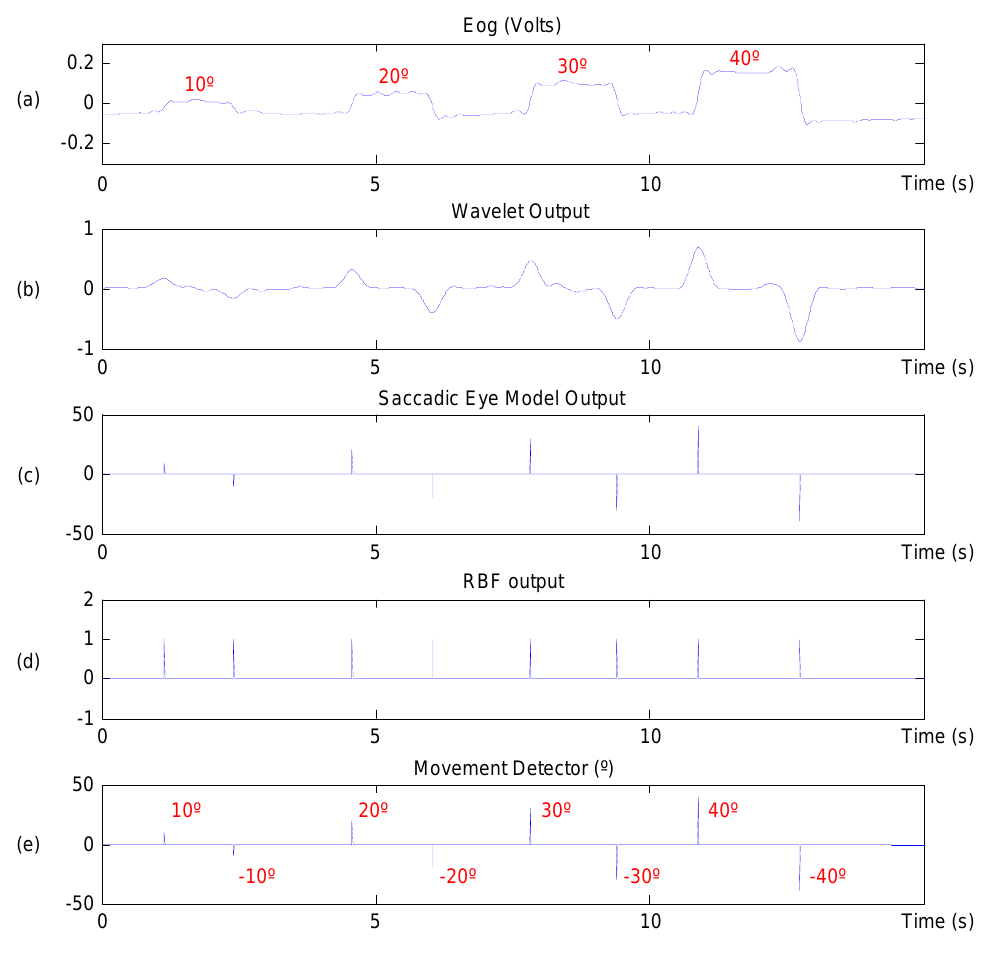
Figure 8. Eye-movement detection process